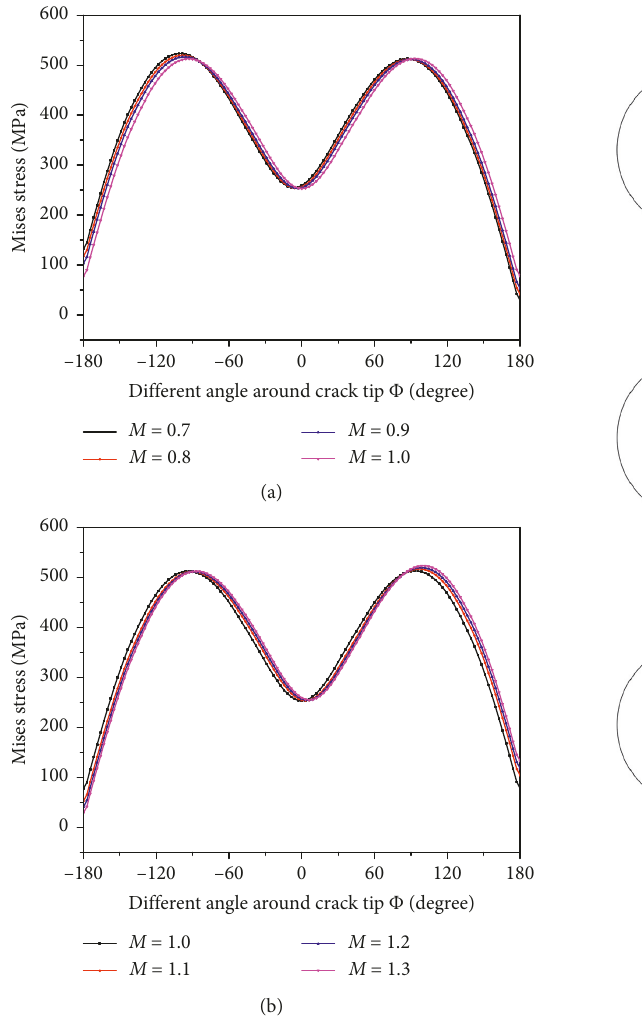
Figure 14: The Mises stress curve of continuous transition model around the crack tip. (a) Mismatch coefficient M ≤ 1. (b) Mismatch coefficient M ≥ 1.